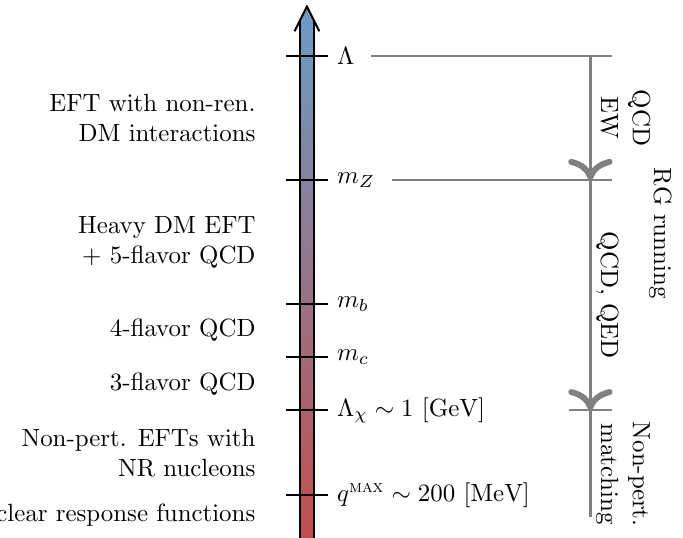
Figure 1 . The tower of EFTs linking the UV scale (cid:3) to the scale of interactions between the nucleons and the